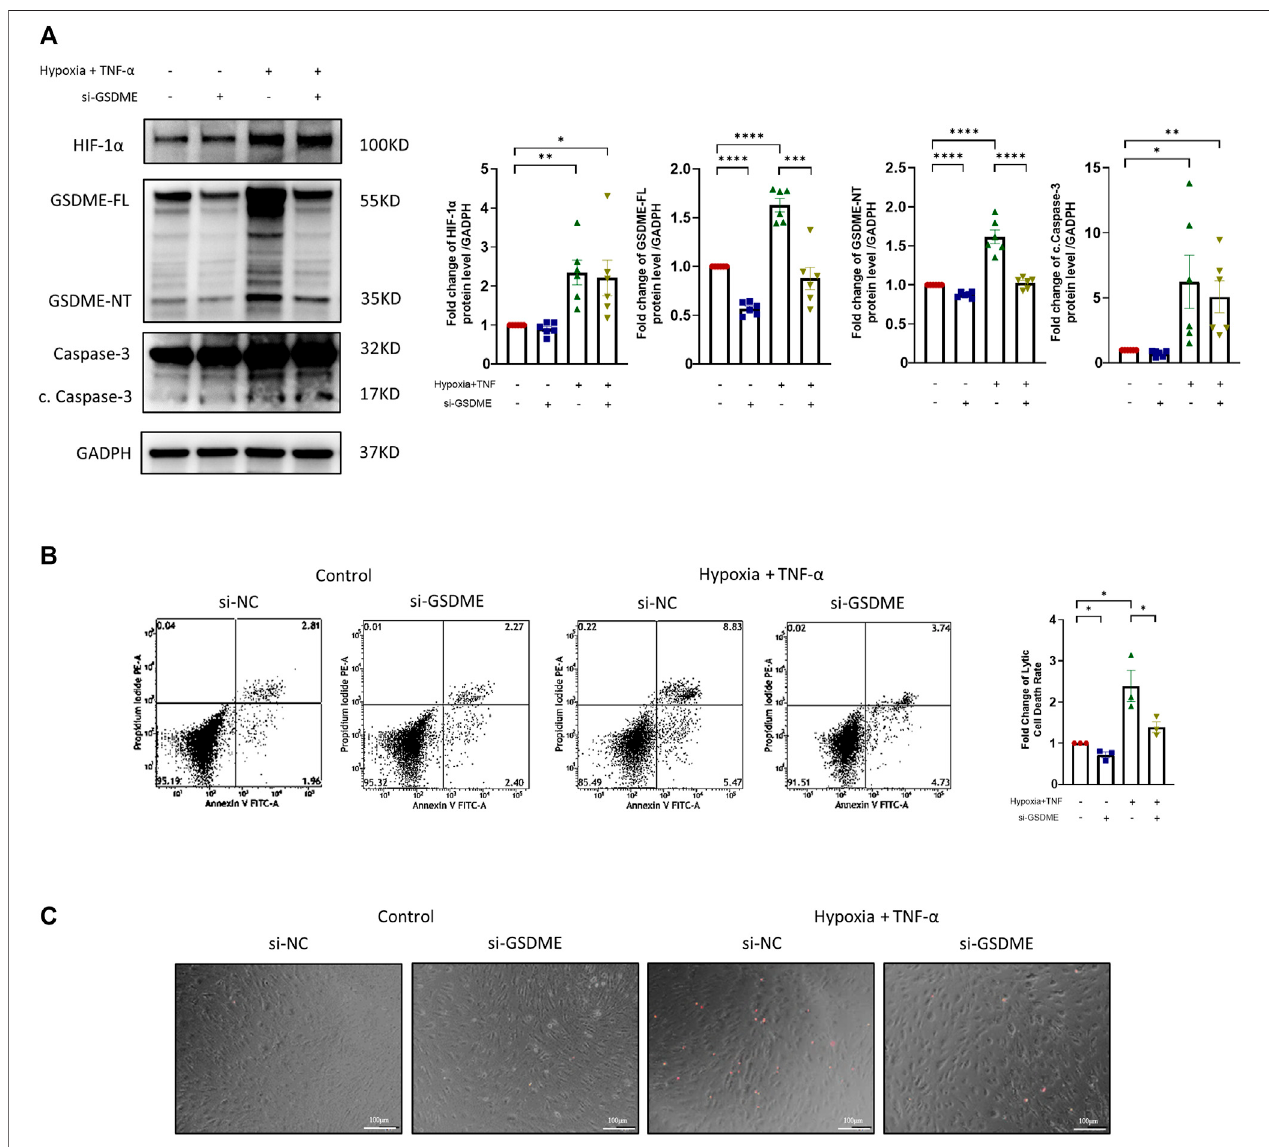
FIGURE 3 | Suppression of RA-FLSs pyroptosis by downregulation of GSDME. (A) Western blot analysis of casepase-3, cleaved caspase-3, GSDME and HIF-1 α of RA-FLSs treated with TNF- α + hypoxia treatment (40 ng/ml, 36 h). GSDME siRNA or control siRNA was transfected for 24 h before treatment ( n = 6). GADPH serves as a loading control. (B) Flow cytometry analysis ( n = 3) and (C) representative phase-contrast images with PI staining of RA-FLSs treated with or without TNF- α + hypoxia (40 ng/ml, 36 h) after 24 h of transfection with GSDME siRNA (si-GSDME) or control siRNA (si-NC). Data are shown as mean ± s. e.m and results are representative of three independent experiments. * p < 0.05, ** p < 0.01, *** p < 0.001, **** p < 0.0001 using one-way